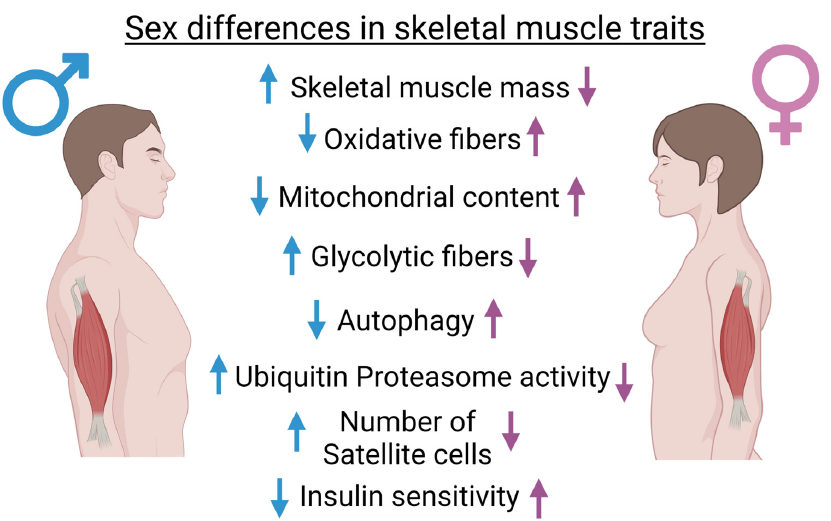
Figure 1. Major differences in muscle phenotypes of the two sexes in humans. Arrows pointing upwards mean stronger expression or higher number compared to the other sex, whereas arrows pointing downwards mean the opposite.